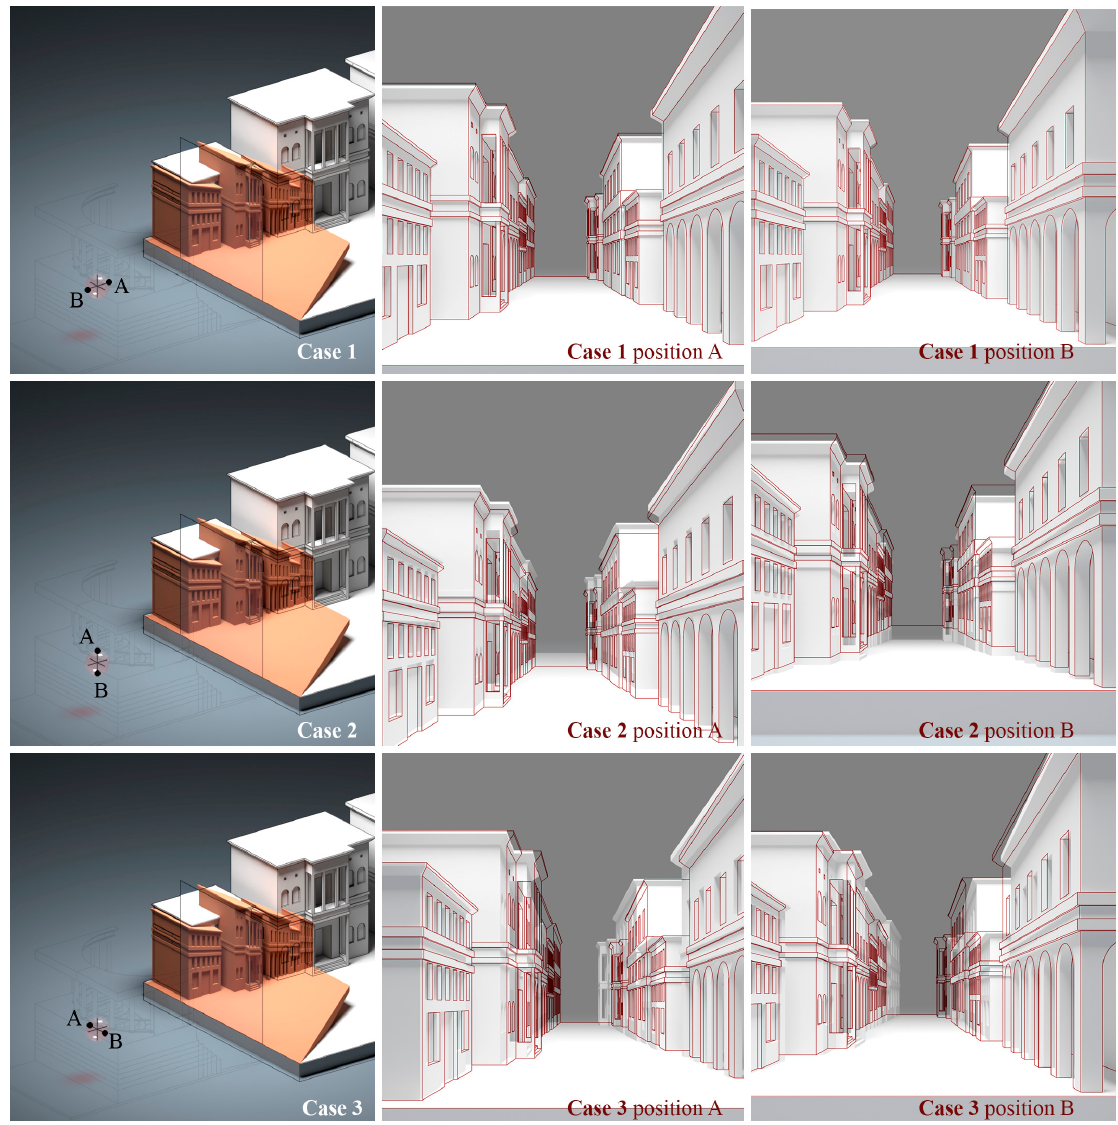
Figure 5. Synoptic picture of the visual perception of the scene seen by an observer placed outside the restricted sight, according to three particular types of motion in case of a relief